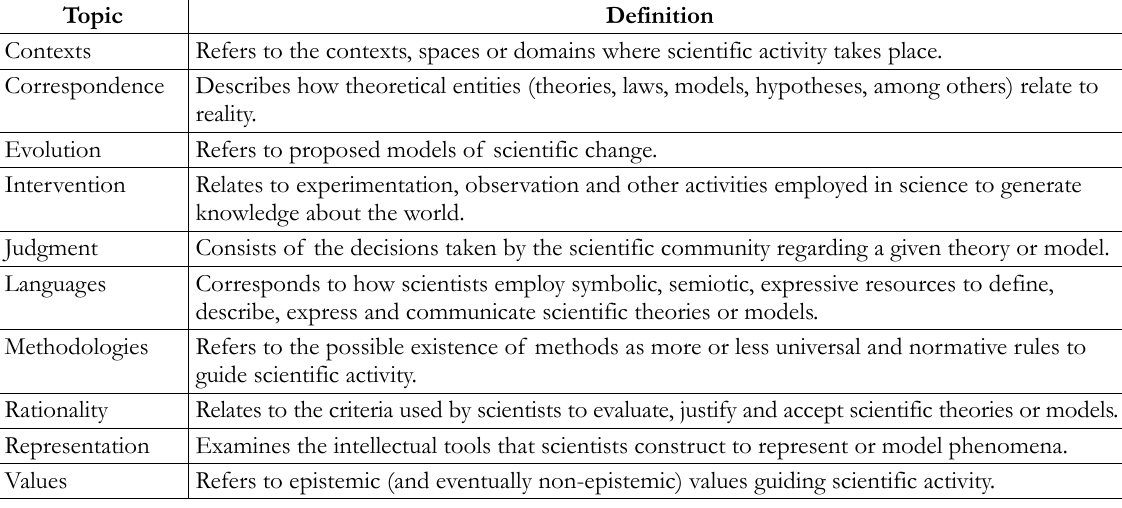
Table 1. Epistemological topics for the study of different specific aspects of